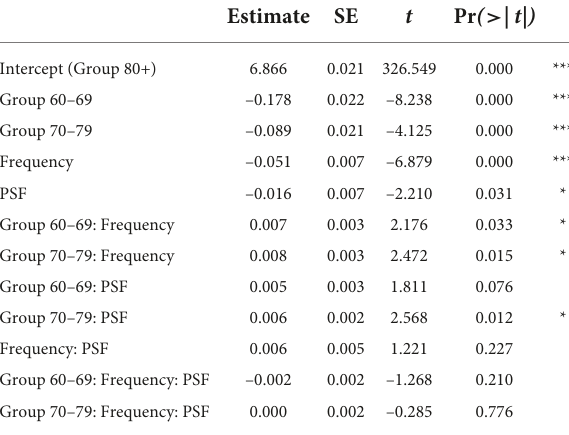
TABLE 1 Linear mixed-effects regression reaction time results for Experiment